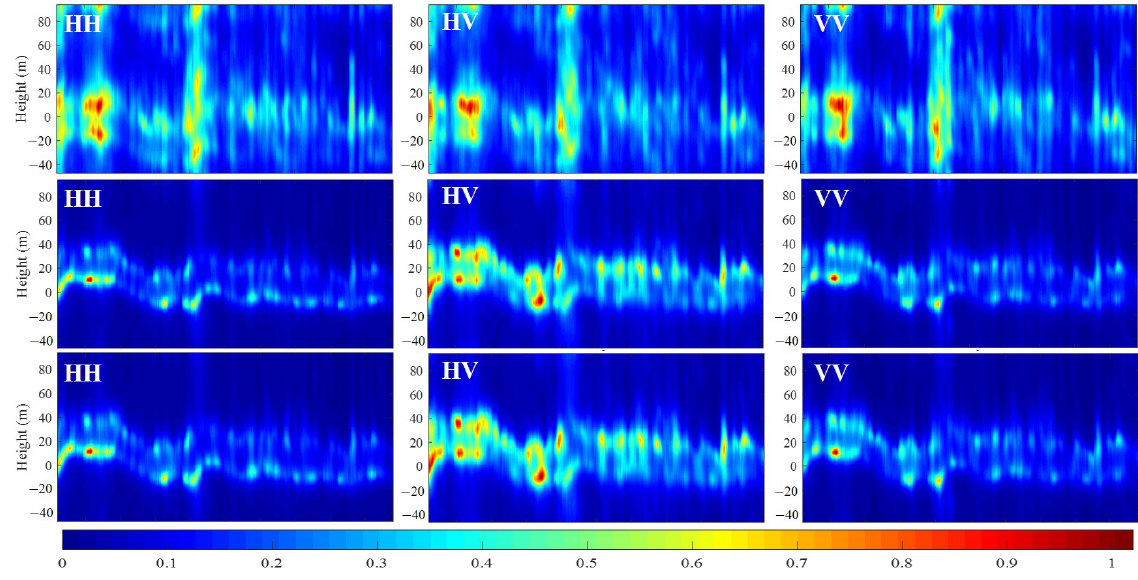
Figure 15. Tomographic imaging on a line. From top to bottom: without PE compensation and with PE compensation using NC-PGA and BBN-PGA